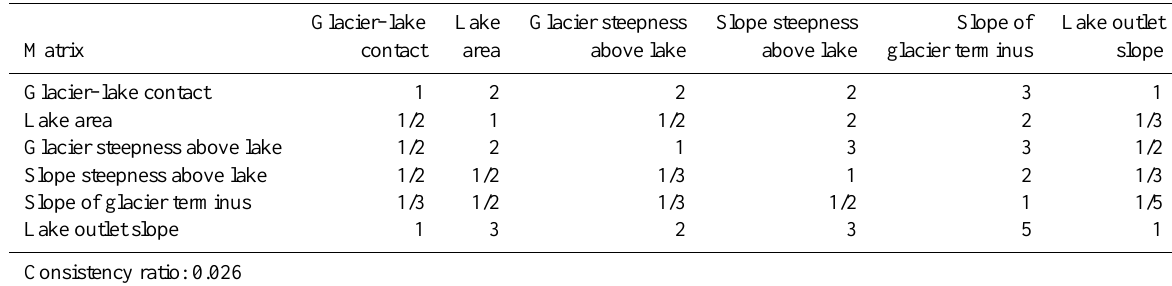
ice avalanches commonly start at slopes ≥ 25 ◦ in